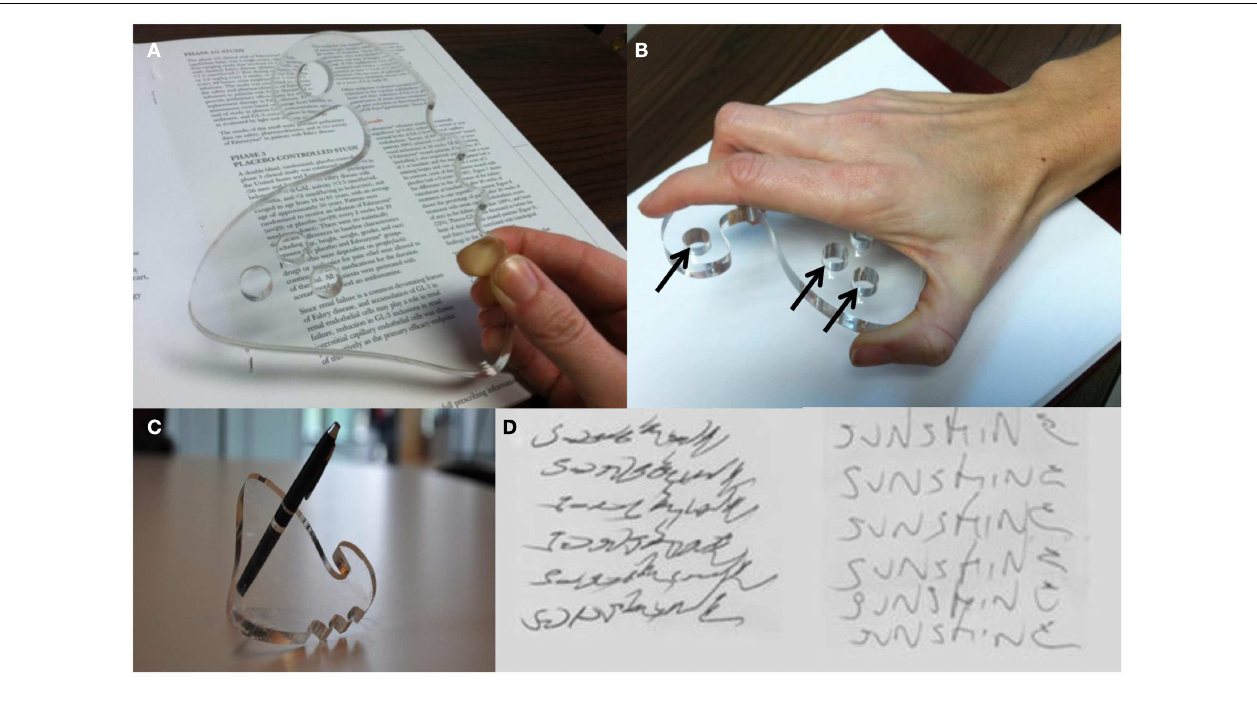
individual handwriting techniques. (C) TheWOD shown with a pen through one of the holes. (D) “Sunshine” writing task before (left) and with the use of theWOD (right) in one of the participating